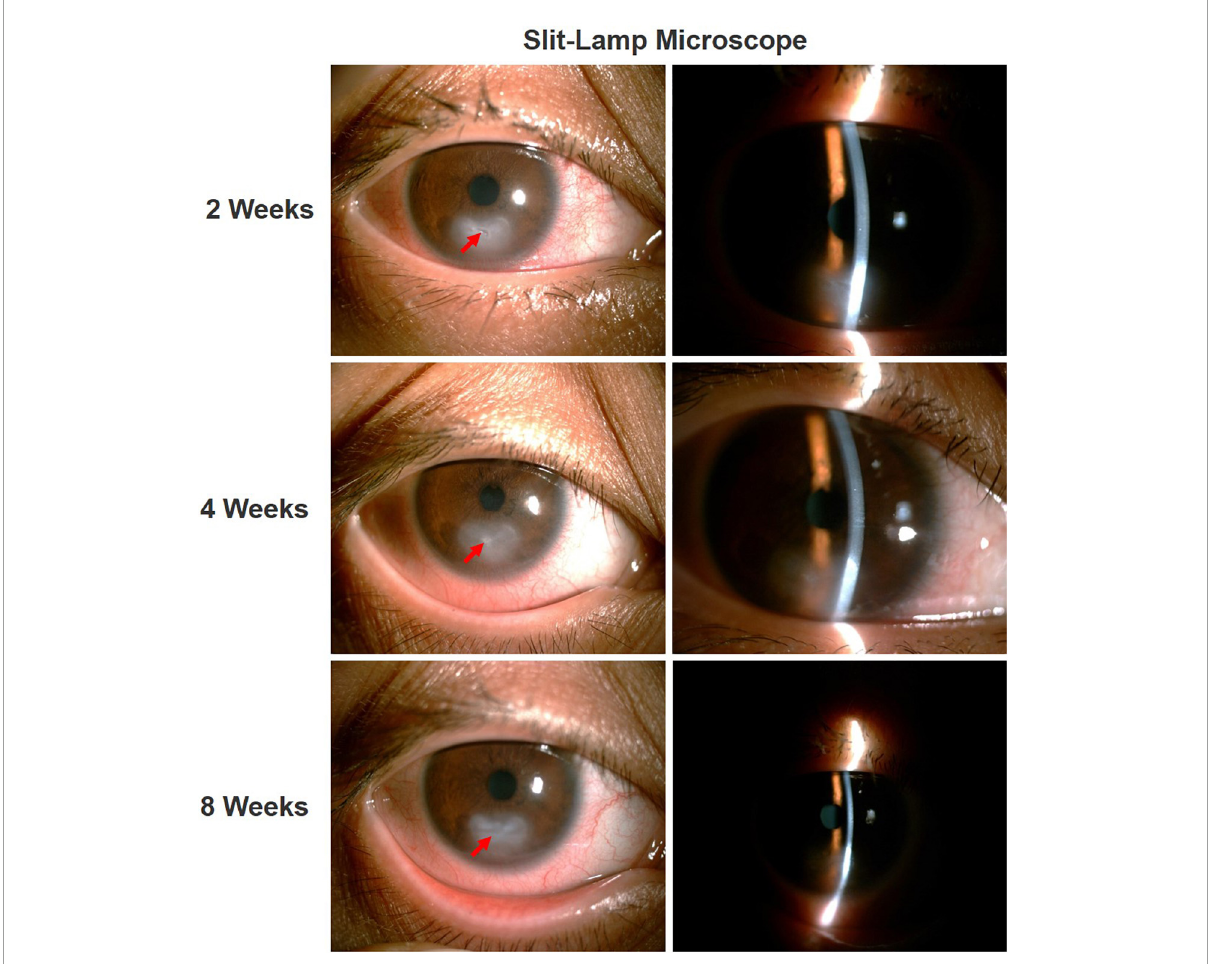
FIGURE4 Ocular condition of right eye after treatment. After treatment, the ciliary hyperemia of the right eye was significantly reduced, the corneal ulcer gradually healed (red arrow), with residual corneal stromal